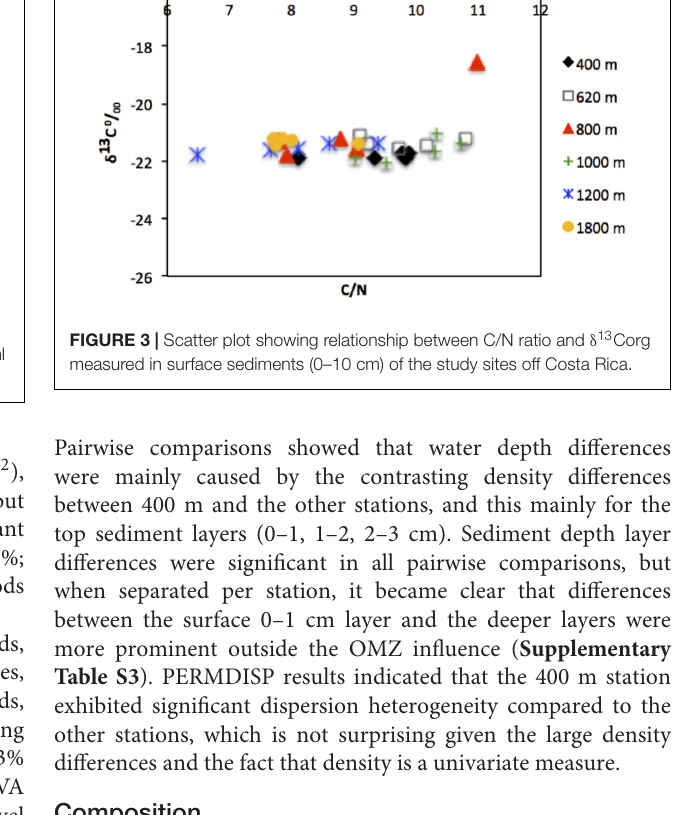
differences and the fact that density is a univariate